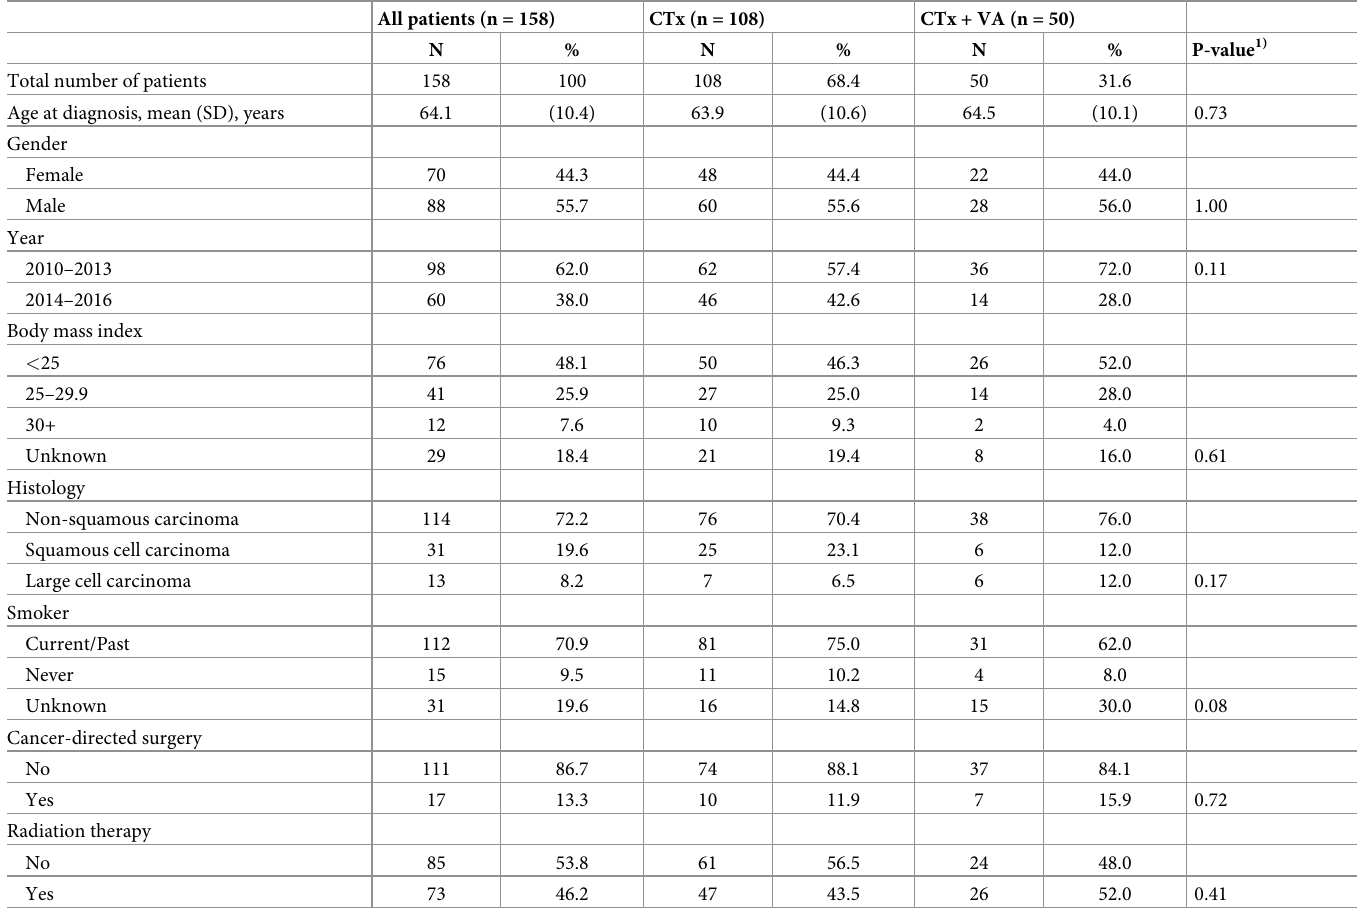
Table 1. Characteristics of patients with stage IV non-small cell lung